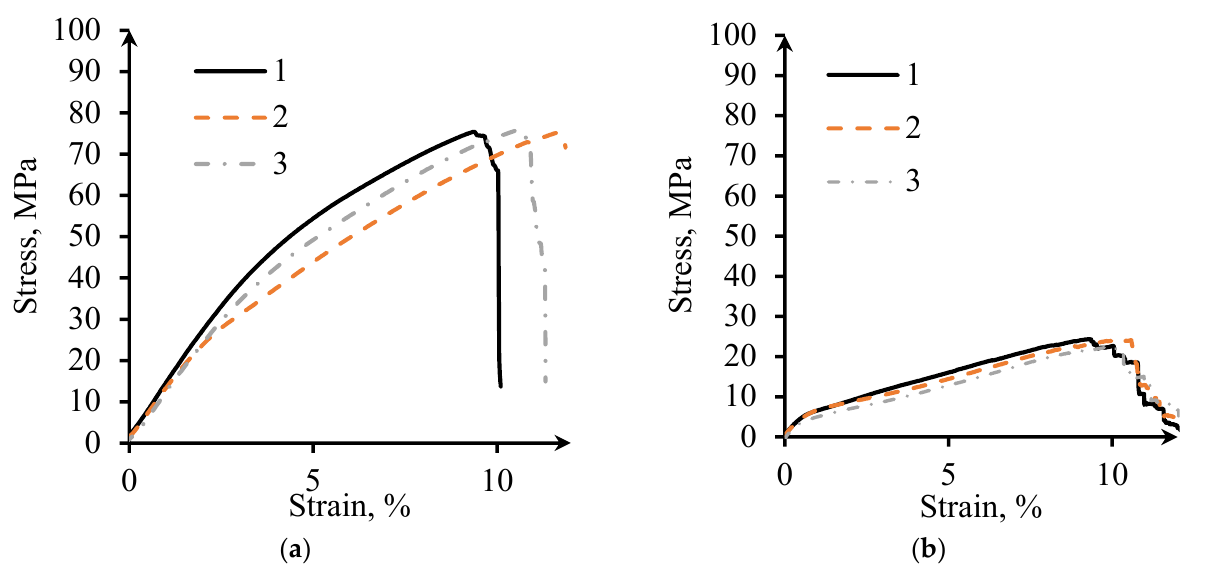
Figure 8. Tension stress-strain curves: ( a ) MT; ( b ) WT.